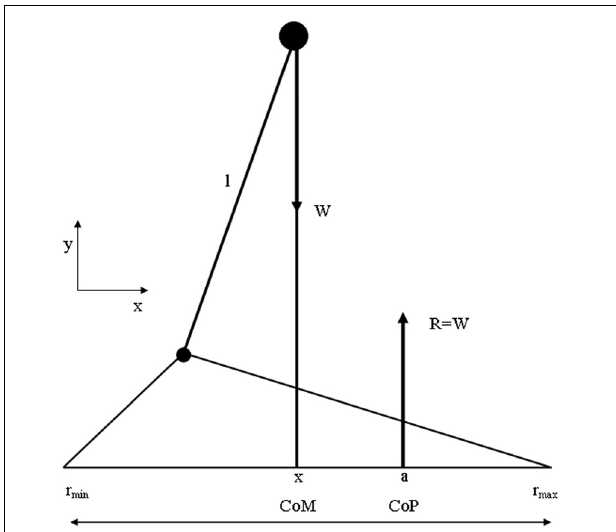
FIGURE 4 | Summary of biomechanical principles. Body center-of-mass (COM)—is the location where all of the mass of the system could be considered to be located. For a solid body it is often possible to replace the entire mass of the body with a point mass equal to that of the body’s mass. This point mass is located at the center of mass. COG—the resultant force of all of small attractive forces of the mass particles of which the body is composed is the body’s weight, and the location at which the resultant force is assumed to act. Ground reaction force vector (GRF)—the resultant of a pressure distribution under the foot or feet. Center- of -pressure (COP)—the location point of the ground reaction force vector (GRF). Body center-of-mass (COM) is regulated through movement of the COP under the feet. In such a model the difference between body COM and COP will be proportional to the acceleration of body COM. Base of support (BoS), is defined as the possible range of the COP, which is loosely equal to the area below and between the feet (in two-feet standing) (Winter et al.,